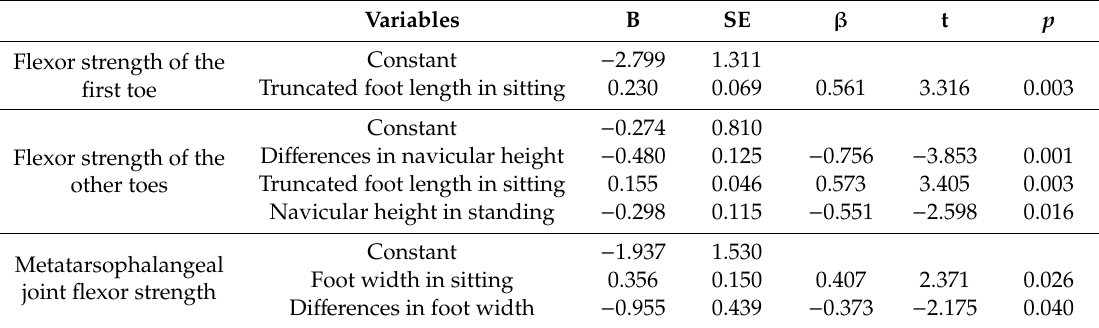
Table 6. Multivariate stepwise regression model of relationships between foot morphology and foot muscle